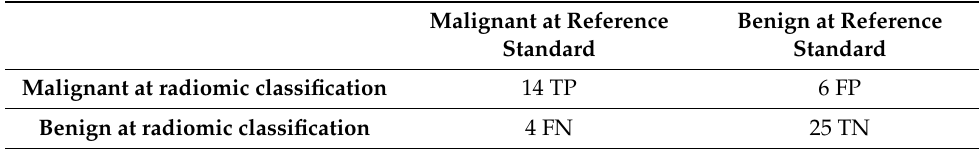
Table 6. Reference standard and radiomic classification results of the tested patients. Number of true positive (TP), true negative (TN), false positive (FP) and false negative (FN). Malignant at Reference Benign at Reference Standard Standard Malignant at radiomic classification 14 TP 6 FP Benign at radiomic classification 4 FN 25 TN However, due to non-negligible FN (4) (error = 4/31 = 19%), our radiomic classifier